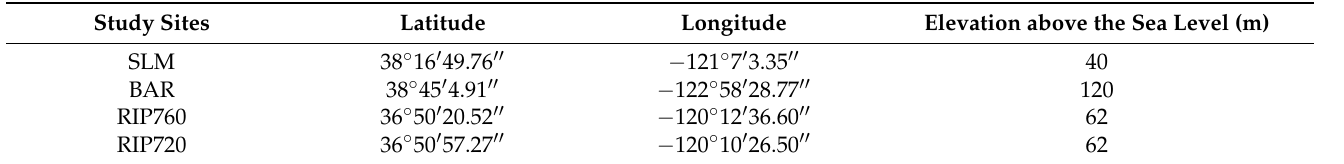
Table A1. Study-site geographic information.